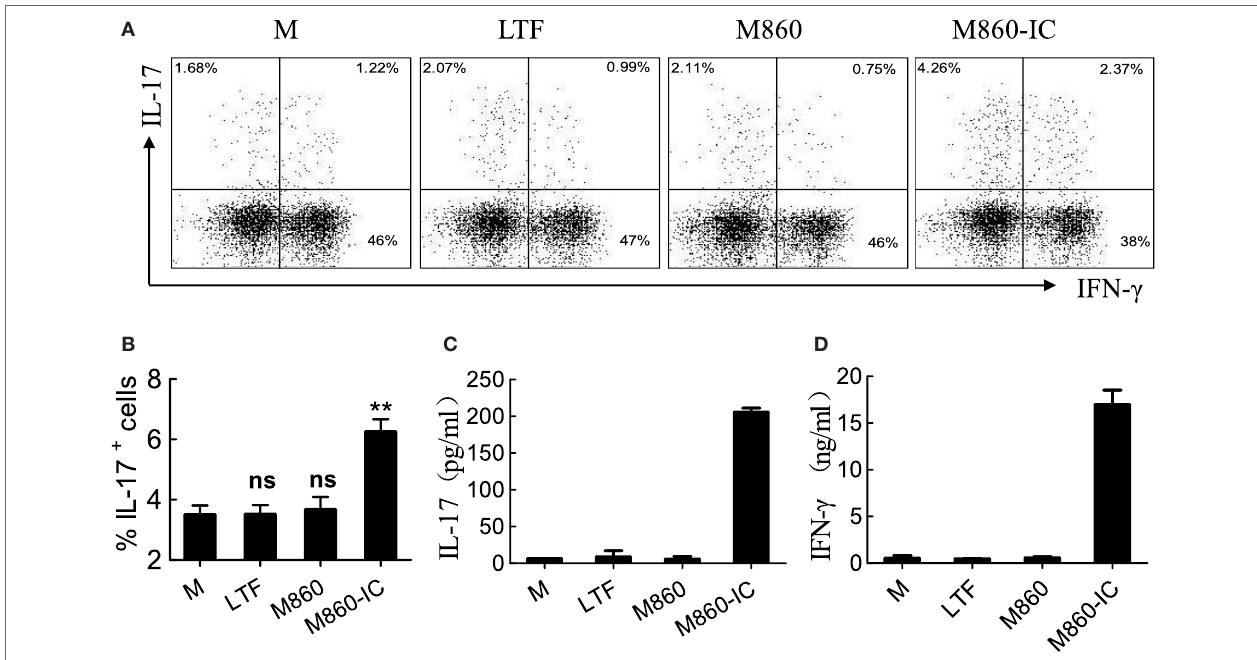
FigUre 6 | (M-CSF)-M2 treated with lactoferrin (LTF)-containing IgG immunocomplex (LTF-IC) promotes Th17 activation. Freshly isolated peripheral blood CD4 + CD45RO + T cells were cultured together with allogeneic (M-CSF)-M2 macrophages that had been pretreated with, or without (M), 30 µg/ml human LTF (Hltf), M860, or M860-IC in tissue culture plates precoated with 100 ng/ml anti-CD3 antibodies for 4 days, followed by restimulation with cell stimulation cocktail. IL-17 (a) and IFN- γ (b) in the supernatants were determined by ELISA. The cells were intracellularly double-stained using FITC-conjugated anti-IL-17 and APC-conjugated anti-IFN- γ for FACS analysis gating on CD4 + T cells (c) . Statistics comparing percent IL-17-positive cells amongst CD4 T lymphocytes in different groups of these cultures are shown (D) . ** P < 0.01. ns, not significant. Data (mean ± SD) are representative of three independent experiments with three biological